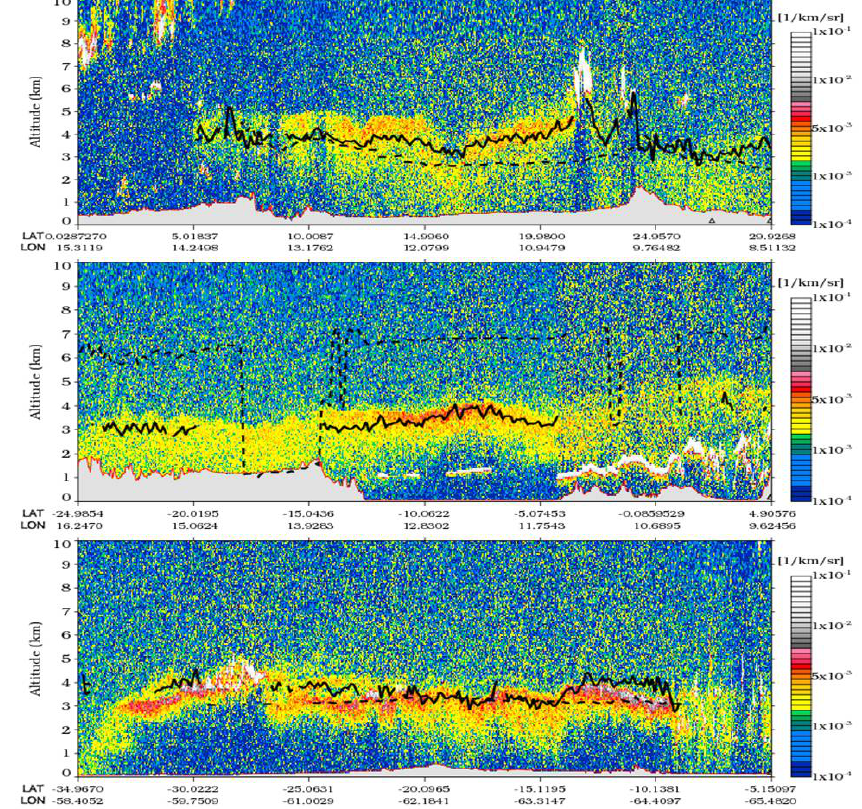
Fig. 5. CALIOP-measured 1064nm backscatter profiles for three aerosol events: desert dust layer over central Saharan (top); smoke layer over Angola and Namibia (middle); smoke layer over central Brazil (bottom). CALIOP-based (solid line) and previously assumed (dashed line) aerosol layer heights are